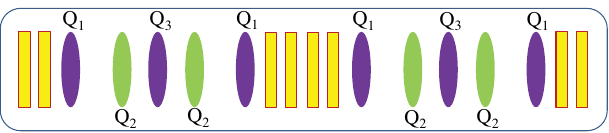
FIG. 11. The layout of the TCAV-based dechirper inside the cryomodule for MITS. Each 13-cell cavity is represented in yellow, while the focusing and defocusing quadrupoles in respect to the ( x , x 0 ) phase space are green and purple,